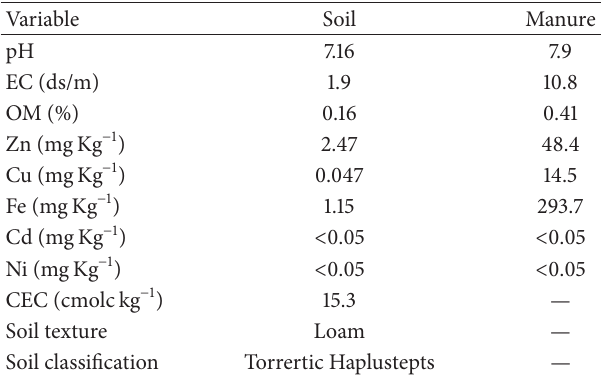
Table 1: Some chemical and physical properties of the soil and